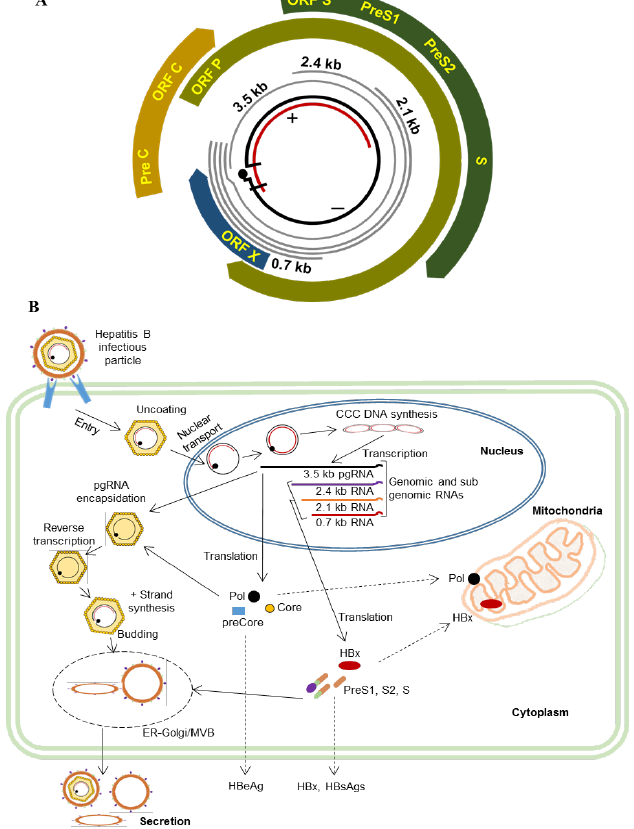
Figure 1. Hepatitis B virus (HBV) genomic map and an overview of the HBV life cycle. ( A ). HBV genomic map. The partially double-stranded DNA encodes four overlapping open reading frames